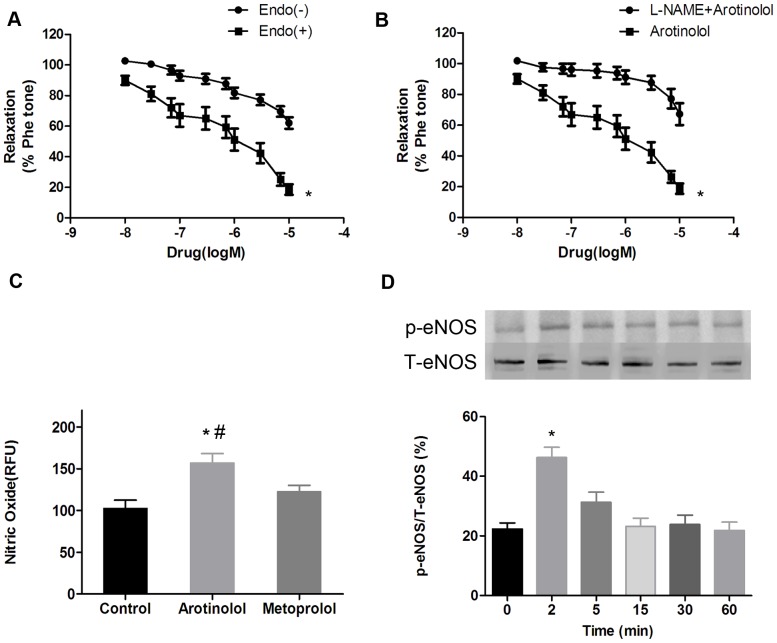
Vasodilations by arotinolol involve endothelium-derived NO.(A) Cumulative concentration-response curves of arotinolol and metoprolol in thoracic aortas with or without endothelium. *
P<0.05 for with vs. without endothelium. (B) Cumulative concentration-response curves of arotinolol in the presence or absence of L-NAME in the rat aortas. *
P<0.05 for arotinolol vs. arotinolol + L-NAME. n = 8 in each group. (C) Effects of different β-blockers on NO production in HAECs. *
P<0.05 for arotinolol versus control. #
P<0.05 for arotinolol vs. metoprolol groups. (D) Effect of arotinolol on p-eNOS/T-eNOS ratios by western blotting assay in HAECs. *
P<0.05 for 2 minutes group vs. control group (0 minute group). n = 12 in each group.